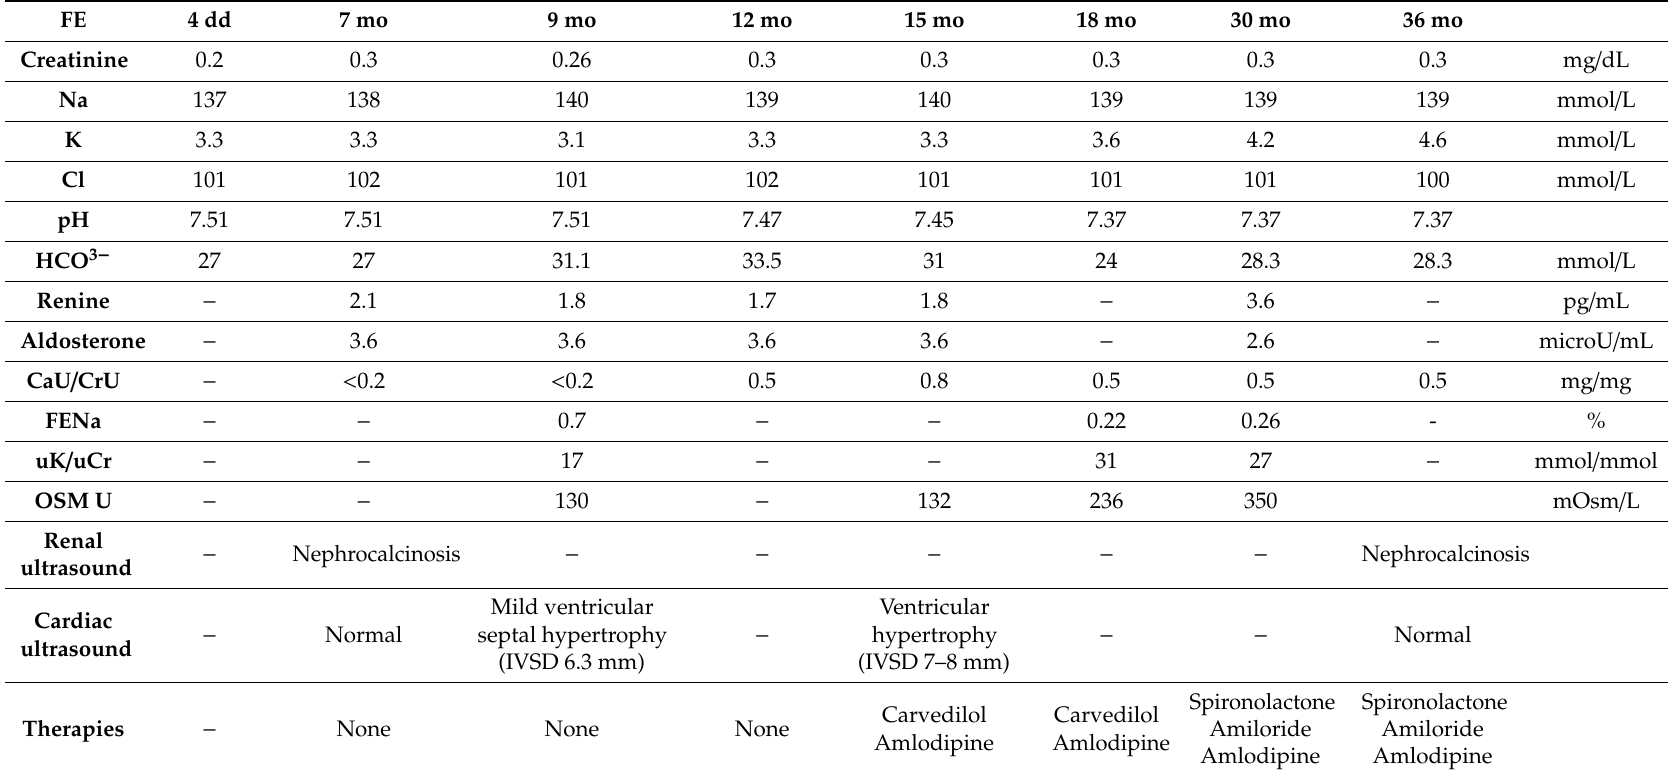
Table 1. Laboratory exams of patient at di ff erent